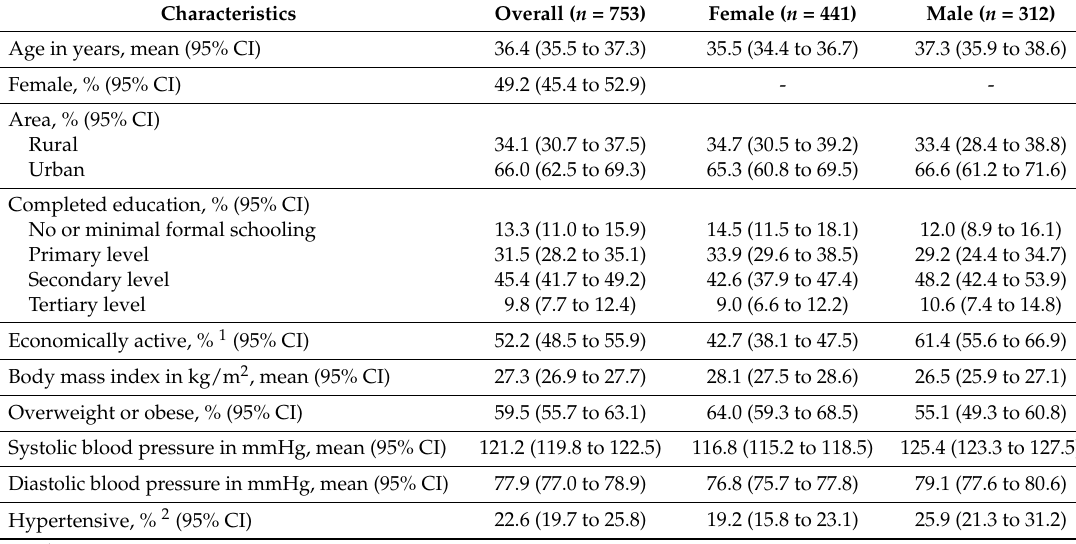
Table 1. Weighted sample